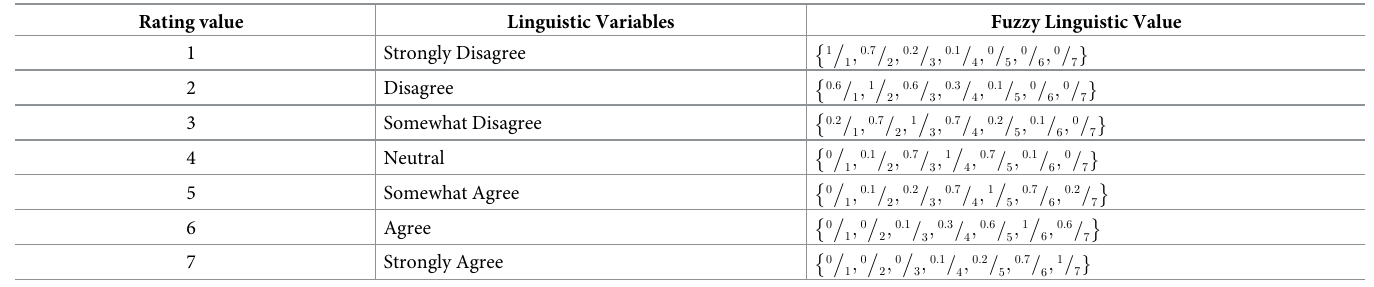
Table 1. Fuzzy linguistic value representing each agreement